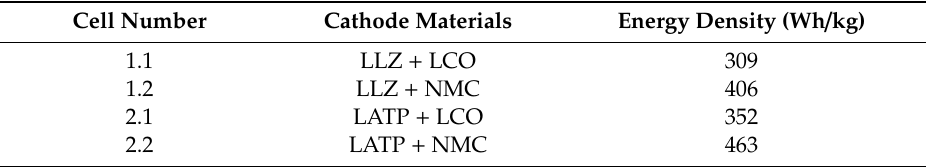
Table 1. Capacities of the four di ff erent cell